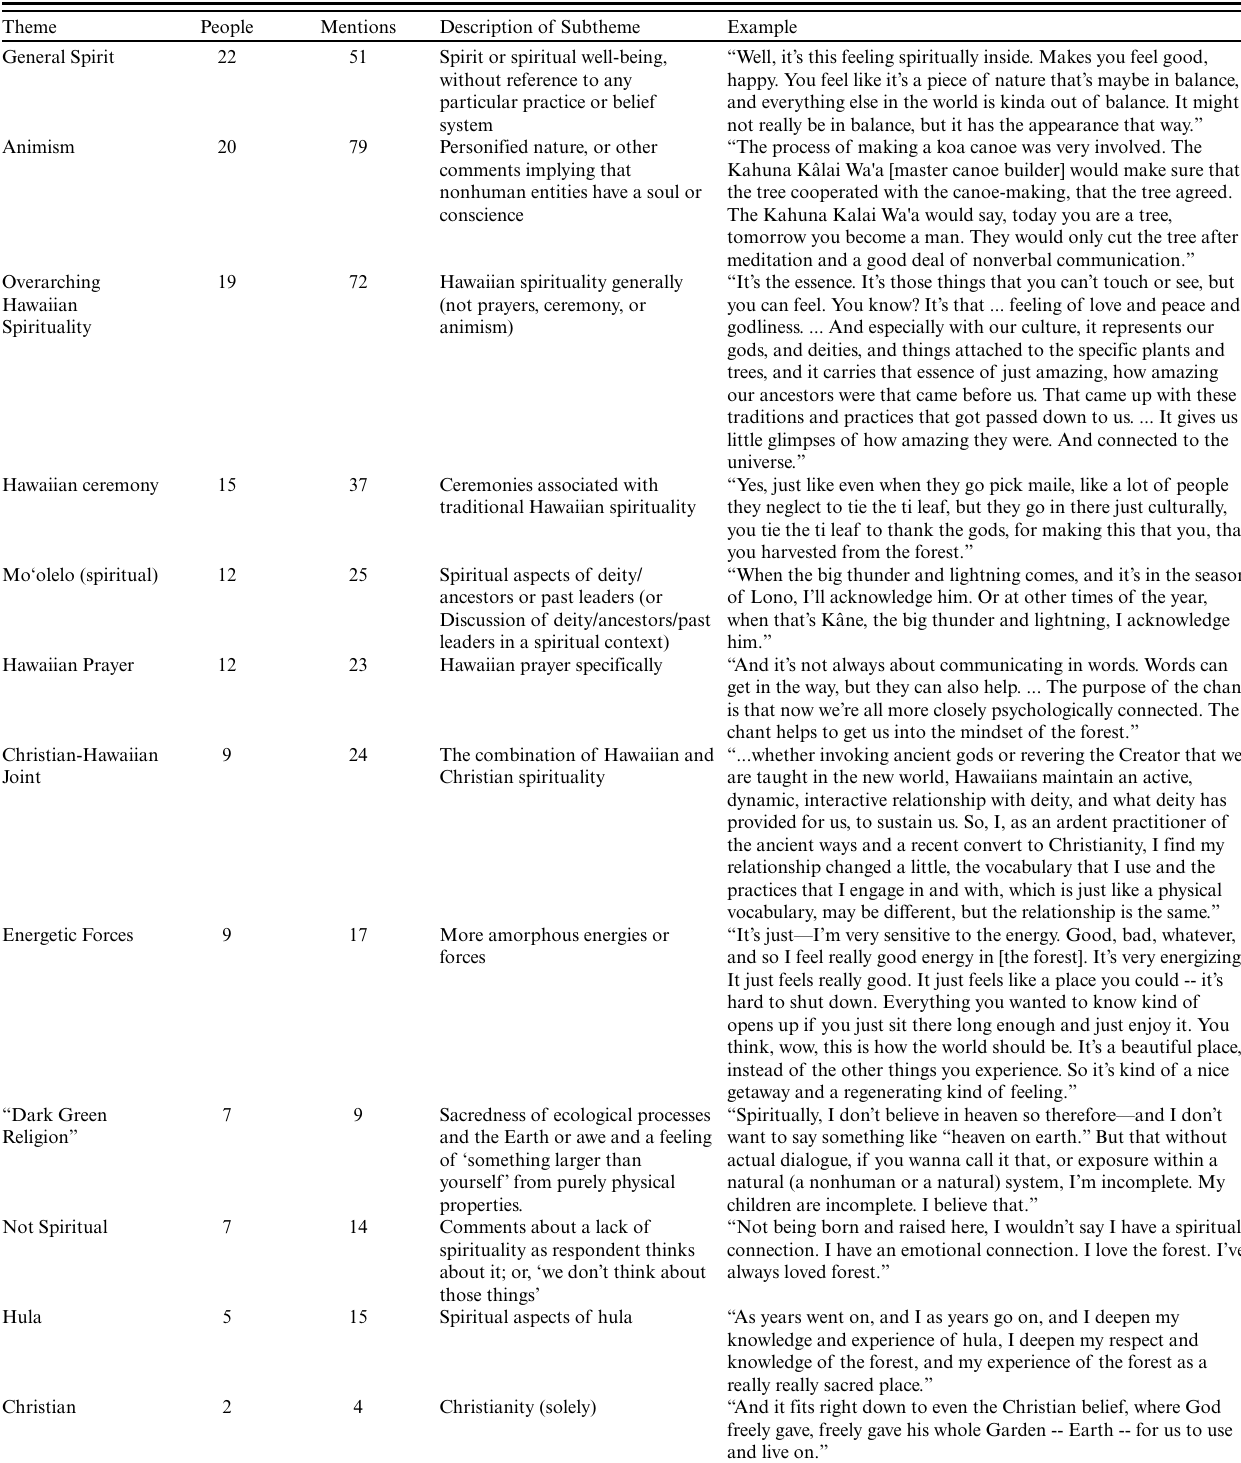
Table 3 . Spirituality subcodes. A division of the 395 references to spirituality into subthemes, with an example provided for each